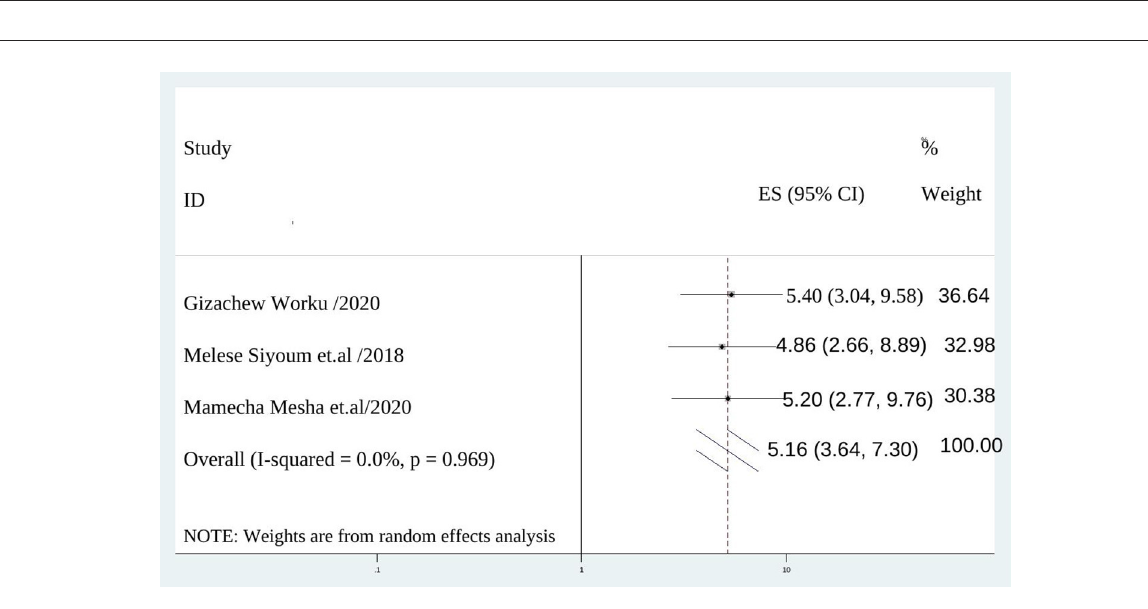
FIGURE7 The association between not satisfied with provided service and discontinuation of long acting reversible